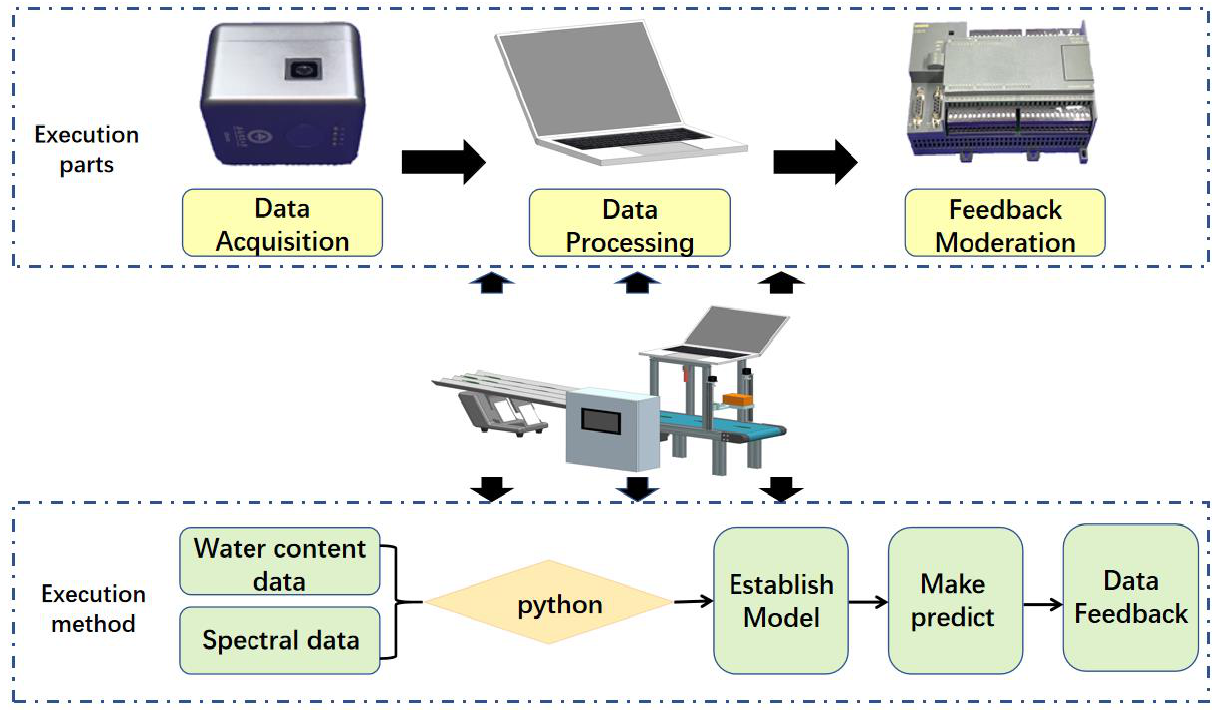
Figure 6. Overall system block diagram.